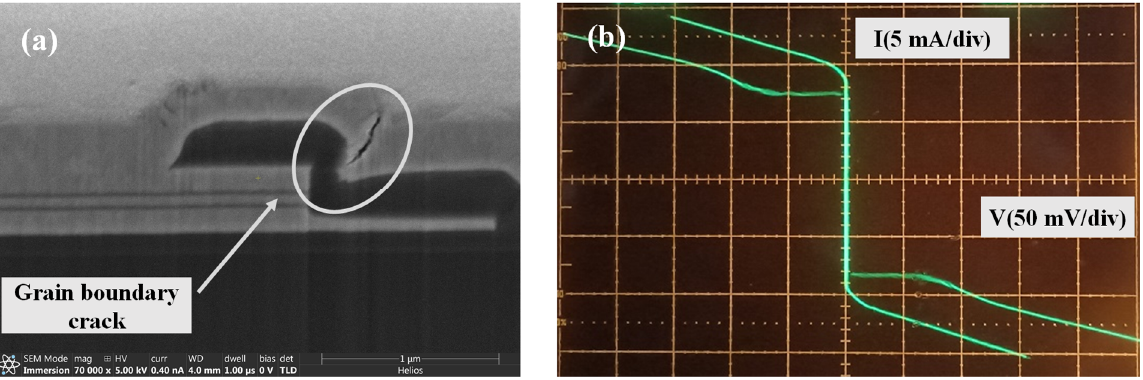
Figure 1. ( a ) Focused ion beam SEM image of an Nb grain boundary crack, and ( b ) hysterical I-V